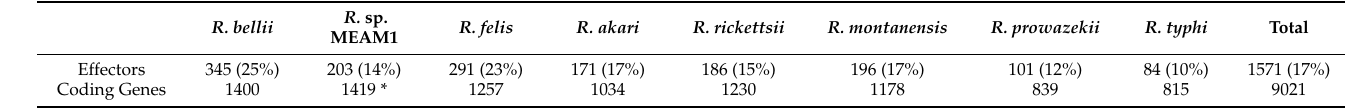
Table 1. Predicted Effectors Compared to Coding Genes across the Genus